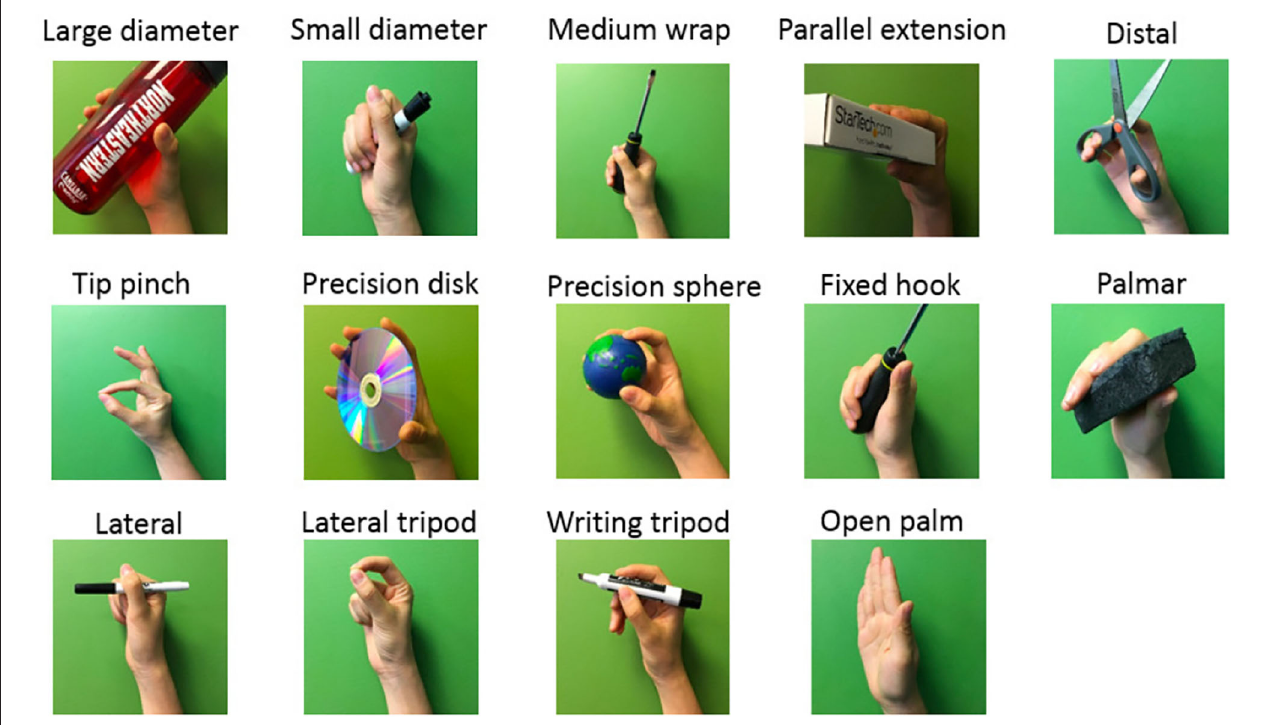
FIGURE 2 | Selected 14 gestures for the classification